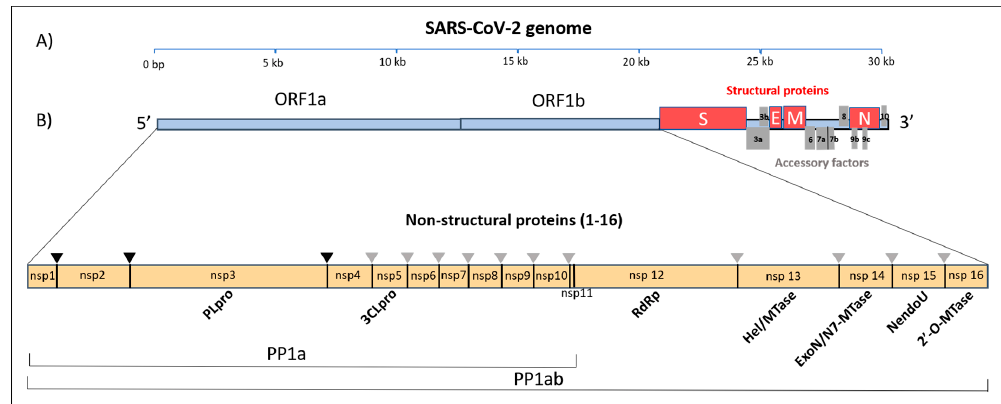
Figure 1. SARS-CoV-2 19 polycistronic genome. ( A ) Genome of SARS-COV-2 organized in individual ORFs. ( B ) Polyprotein 1ab (PP1ab) embeds 16 non-structural proteins (Nsps); the black and grey triangles indicate the cleavage sites of the protease PLpro and 3CLpro, respectively. Names of confirmed and putative functional domains in the Nsps are also indicated.